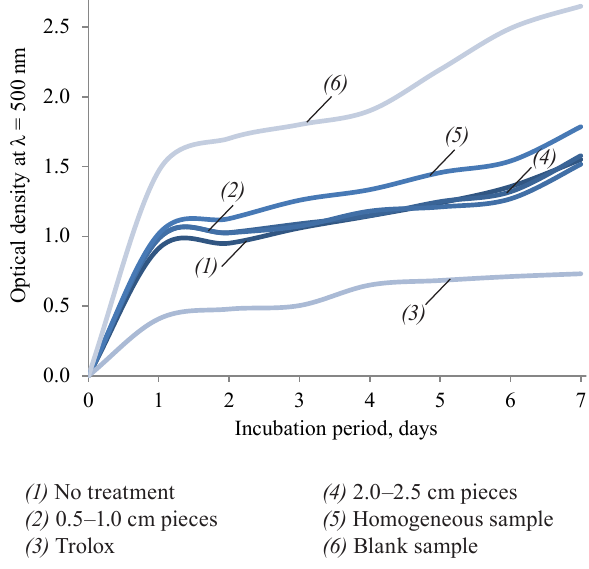
Figure 1 Effect of preliminary grinding on the LPO inhibition of the freeze-dried product. (Note: in Figs. 1–3, a lower optical density at 500 nm corresponds to a higher LPO